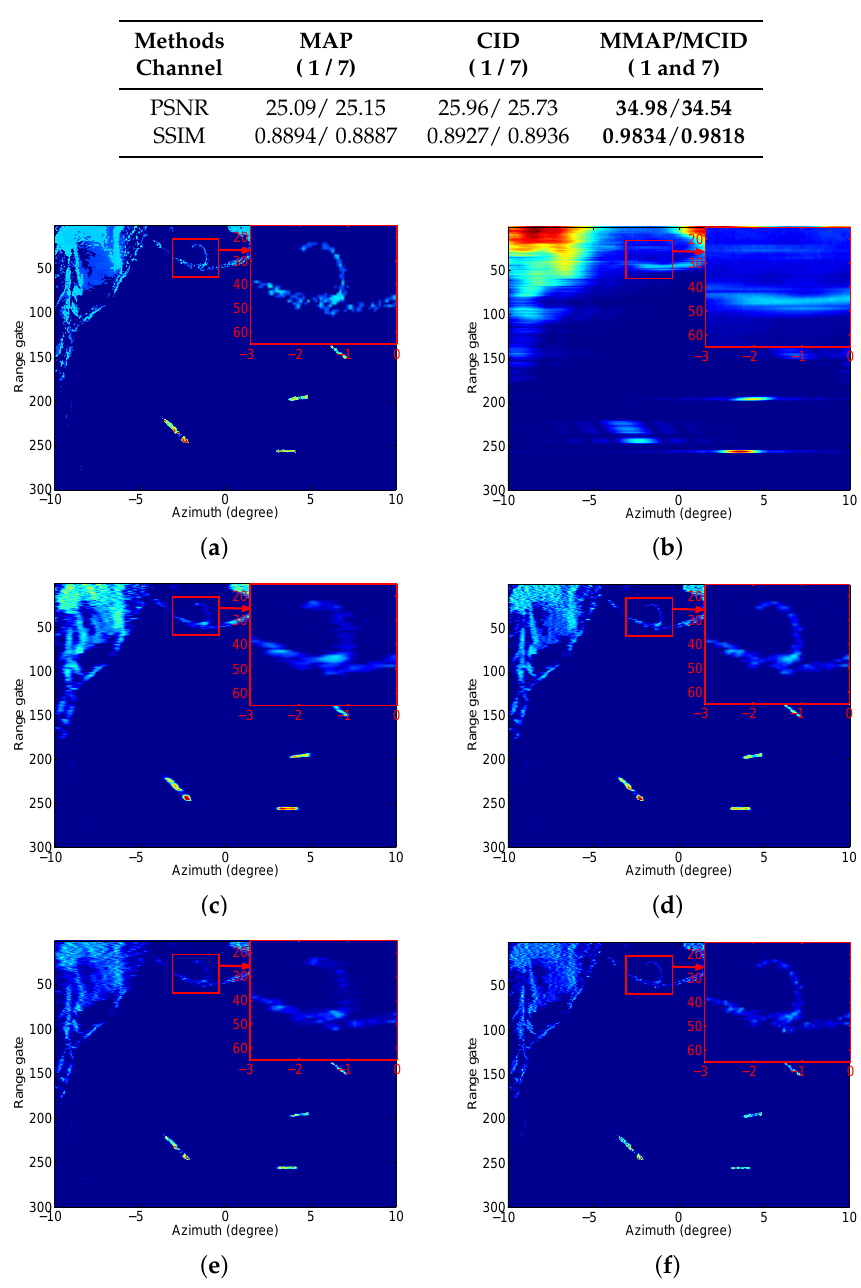
Figure 12. Scene simulations. ( a ) Original scene; ( b ) Real aperture imaging result after pulse compression; ( c ) MAP; ( d ) proposed MMAP; ( e ) CID; ( f ) proposed